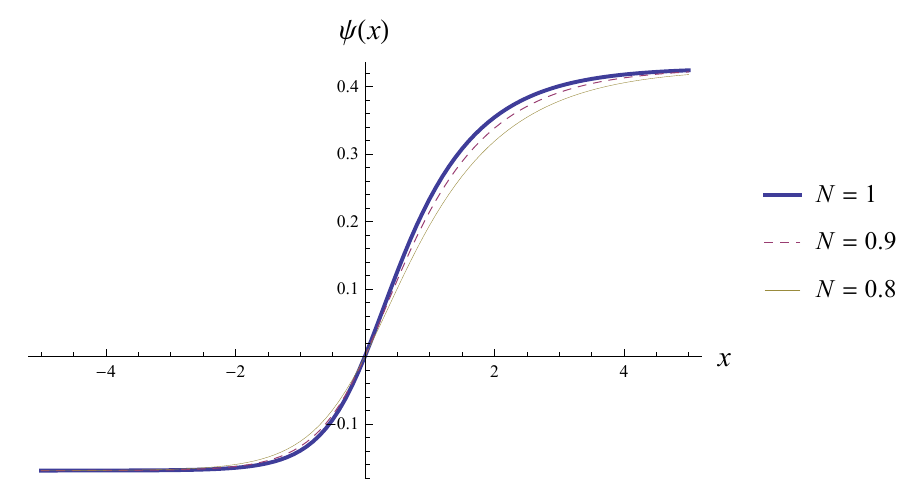
Figure 1. Plots of ψ ( x ) for H = 1/2 (the canonical sector) and N = 1, 0.9, 0.8.